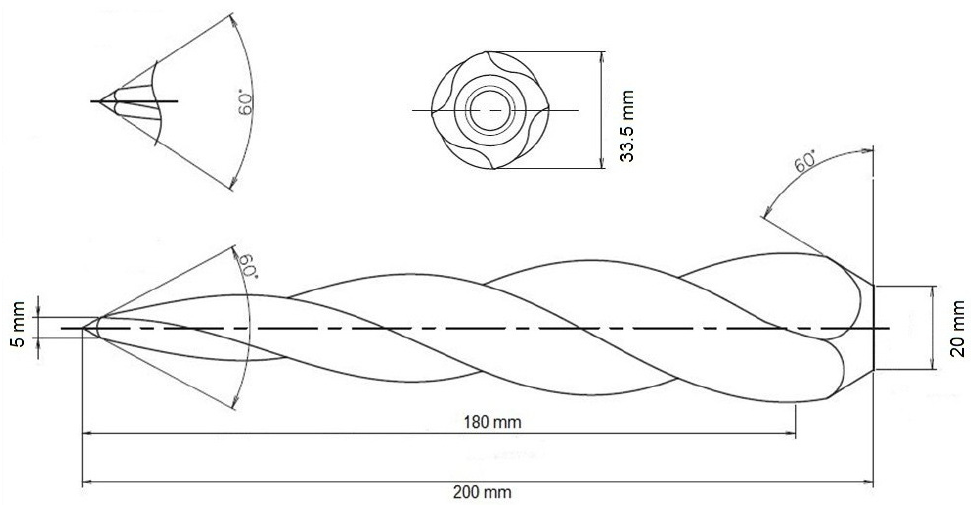
Figure 4. Schematic view of the screw point with dimensions.